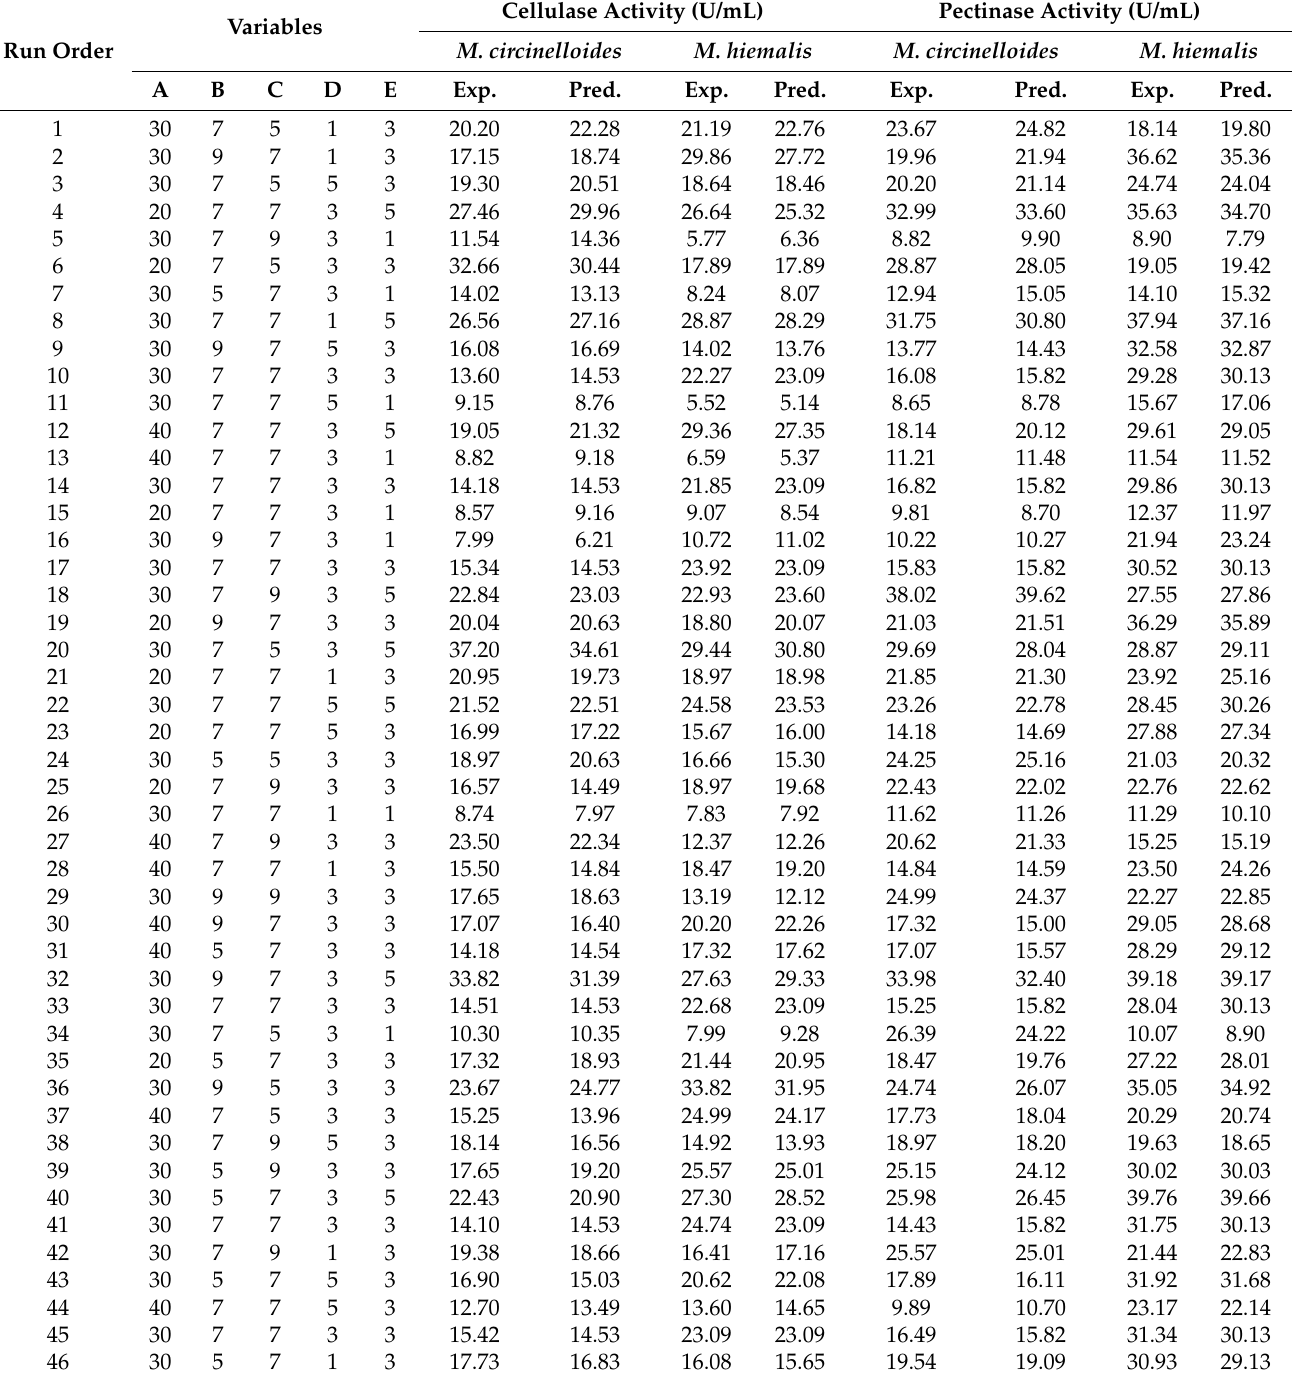
Table 3. Box–Behnken design of optimization variables with experimental and predicted cellulase and pectinase activities of both M. circinelloides and M. hiemalis